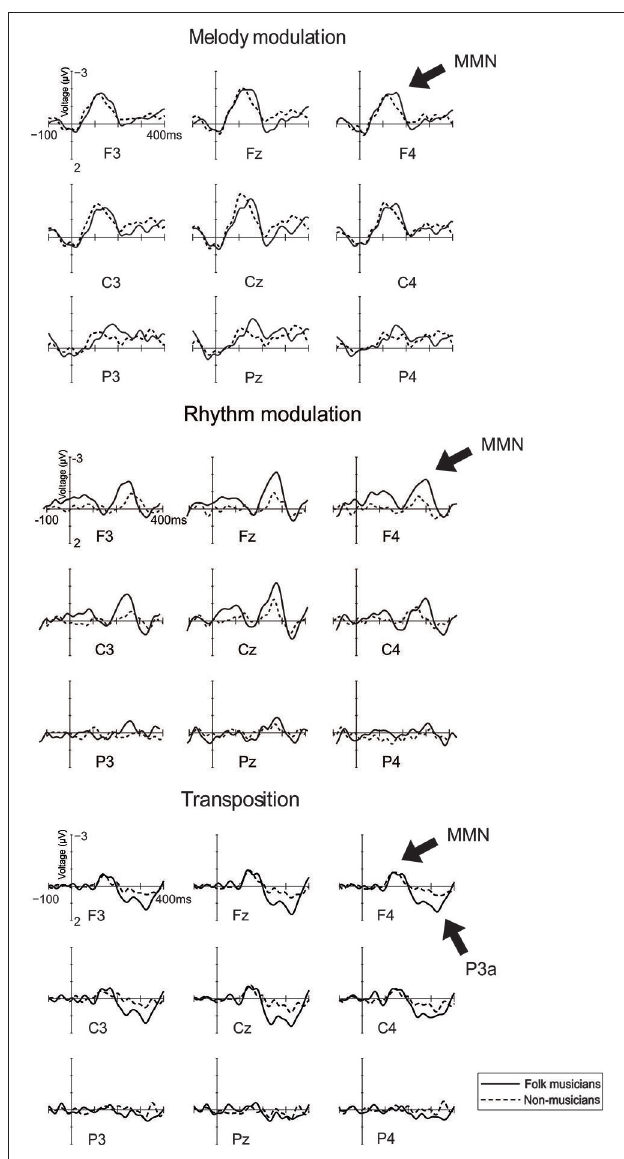
FIGURE 3 | Brain responses to Rhythm modulation, Melody modulation, and Transposition . These changes were introduced in the melody and they modulated its